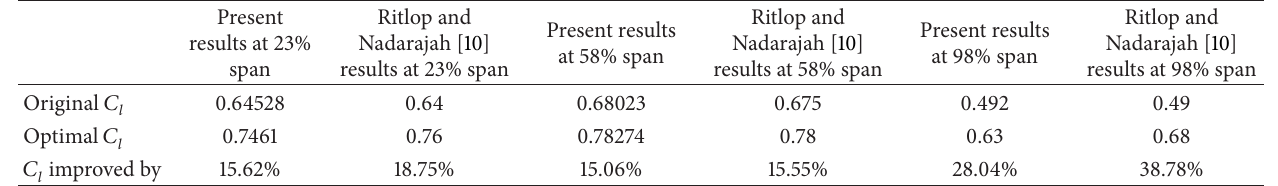
Table 5: Comparison of 𝐶 𝑙 of optimized airfoils: present results and those of Ritlop and Nadarajah [10].